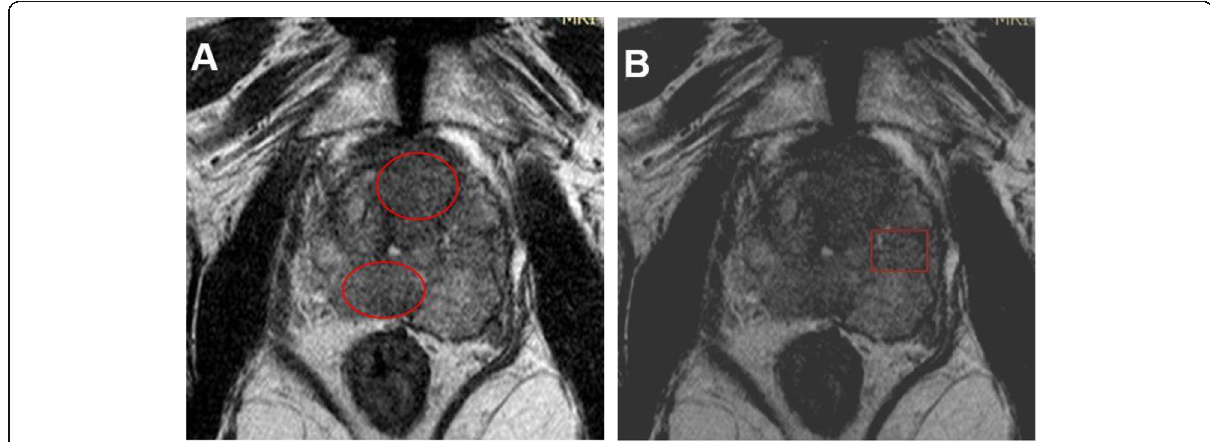
Fig. 1 The false-positive prediction from the 60-tag iteration: a radiologist identified 2 lesions at anterior transition zone and right peripheral zone (red circle) in a testing image. b AI predicted lesion (red rectangle) at the peripheral zone which was a false